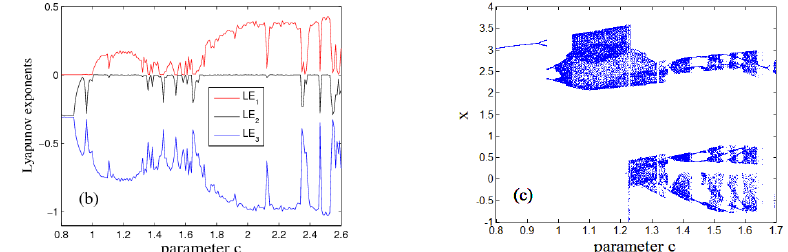
Figure 2. ( a ) Bifurcation diagram, ( b ) Lyapunov exponent spectra versus c , and ( c ) the enlarged drawing of ( a ).